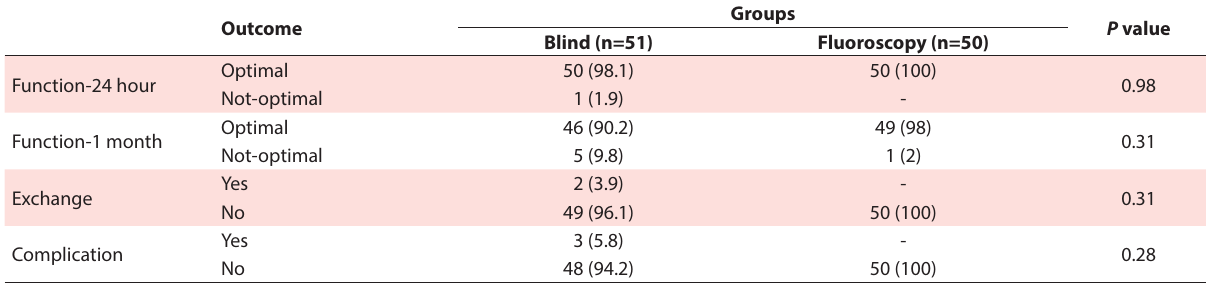
Table 3. Comparison of outcome between the two groups Outcome